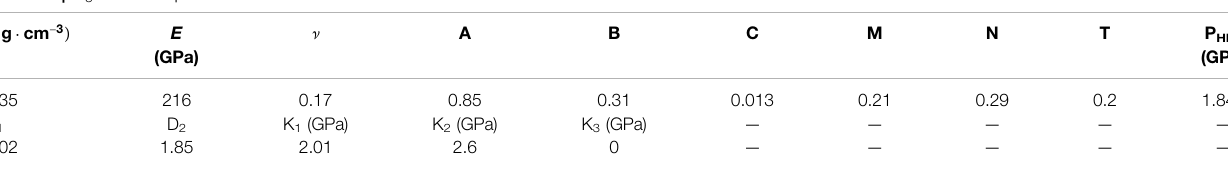
TABLE 2 | Al 3 Ti material parameters.